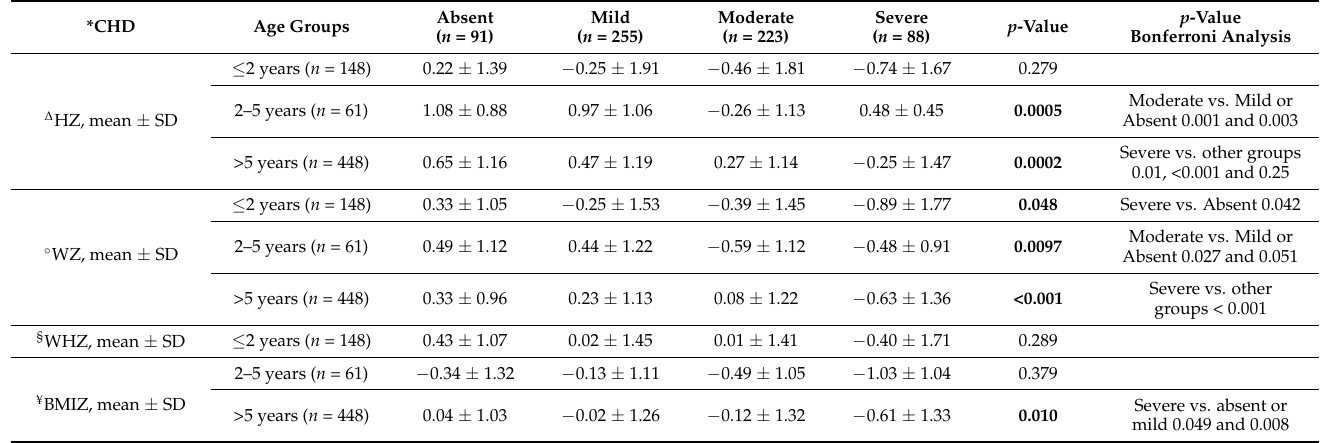
Table 3. HZ, WZ, BMIZ and WHZ divided for age groups and stratified for CHD severity.